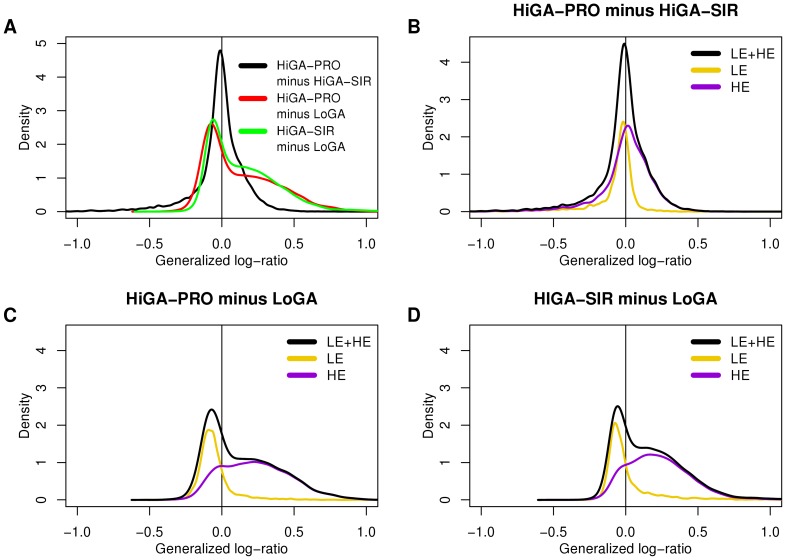
HiGA-PRO and HiGA-SIR show a massive transcriptional activation compared to LoGA.This activation can be attributed to the HE genes but not to the LE genes. No such massive differences in expression can be seen between HiGA-PRO and HiGA-SIR. Shown are densities (kernel density estimates of the distributions) of gene-wise generalized log-ratios (estimated log fold changes) between the CAPs. A) The three densities correspond the contrasts: HiGA-PRO minus HiGA-SIR (black line), HiGA-PRO minus LoGA (red line) and HiGA-SIR minus LoGA (green line). Each density includes all probe sets with unique Entrez IDs (n = 12679). B,C,D) Densities of the estimated log fold changes of the HE and LE genes in the three contrasts from A. The densities are scaled such that the sum of the density of the LE genes (yellow line) and the HE genes (violet line) equals the density of LE and HE genes together (black line). In B, C and D only probe sets with unique Entrez IDs which could be classified to the LE (n = 3585) or HE (n = 7325) groups are included.